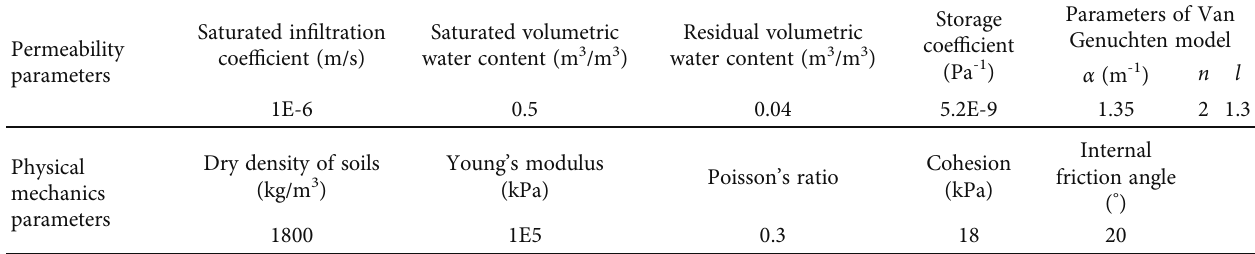
Table 1: Permeability parameters and physical mechanics parameters of slope model.